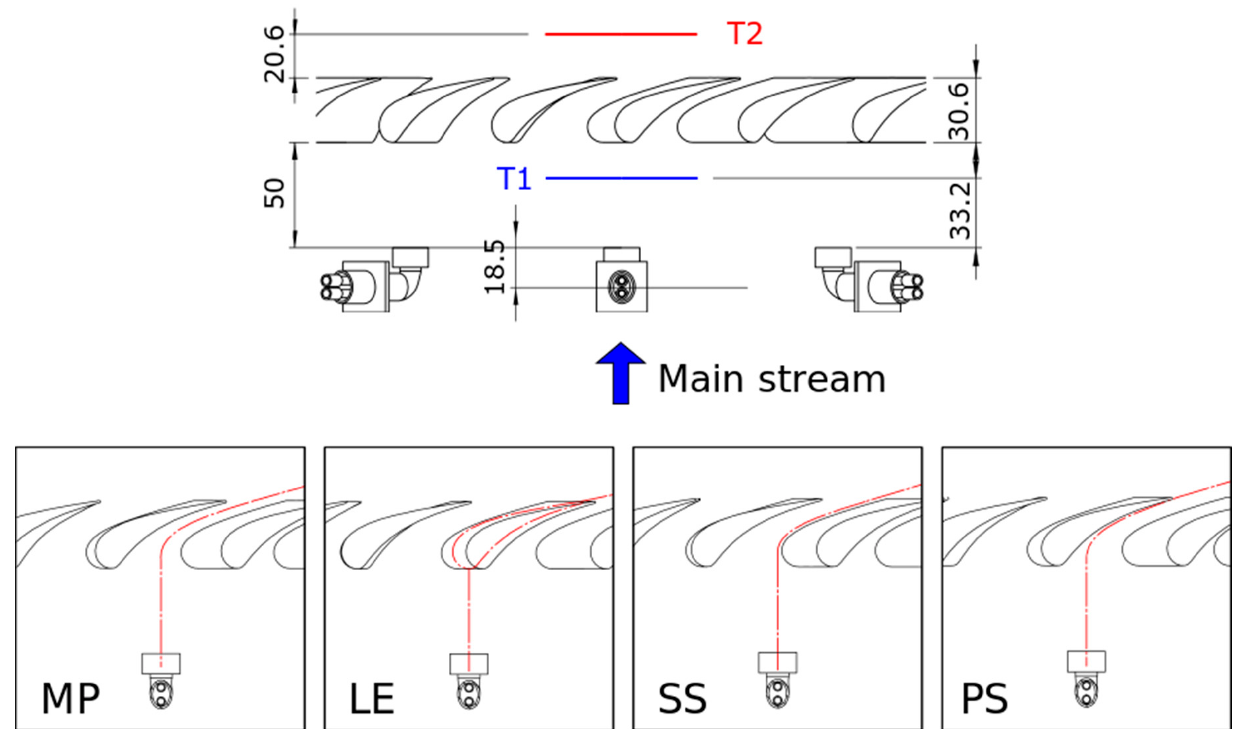
Figure 2. EWG set-up. Top: main geometrical distances. Bottom: injection